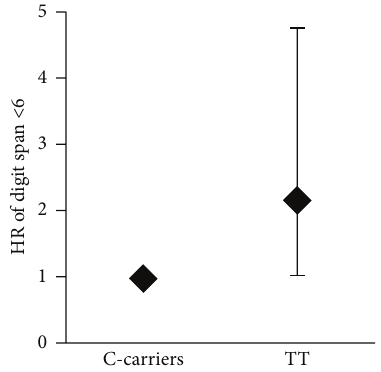
Figure 2: Relative risk (RR) of performing low digit span in relation to C825T polymorphism of GNB3 gene; 95% confidence intervals are also